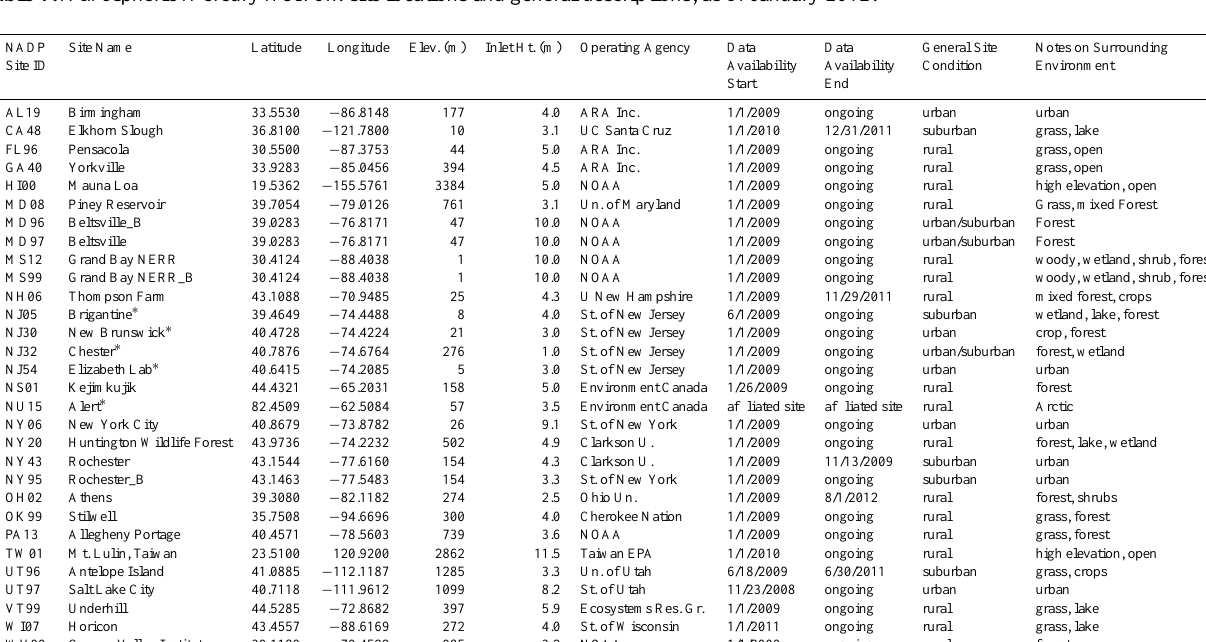
Fig. 1. Atmospheric Mercury Network sites, as of January 2012 (stars). Table 1. Atmospheric Mercury Network site locations and general descriptions, as of January